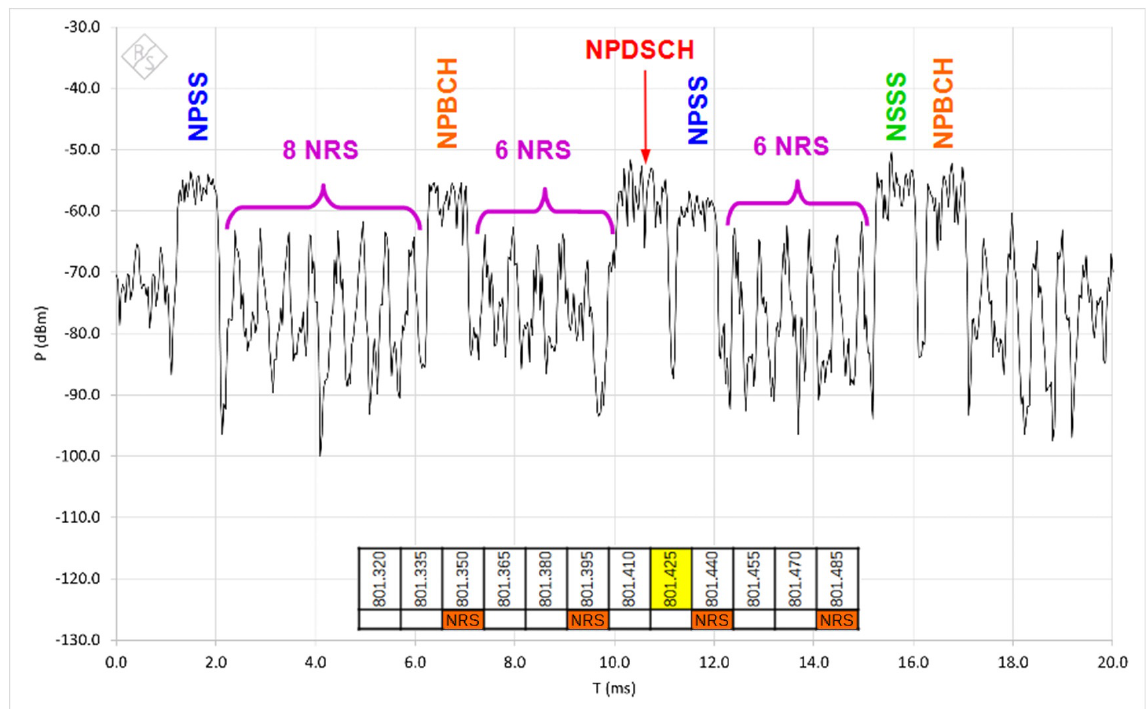
Figure 9. Example of time acquisition of last subcarrier (801.485 MHz).